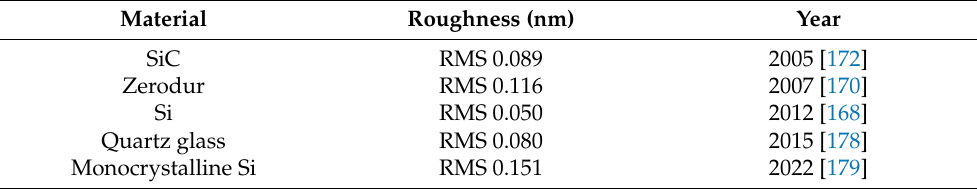
Table 7. The ultimate roughness achieved with EEM for different